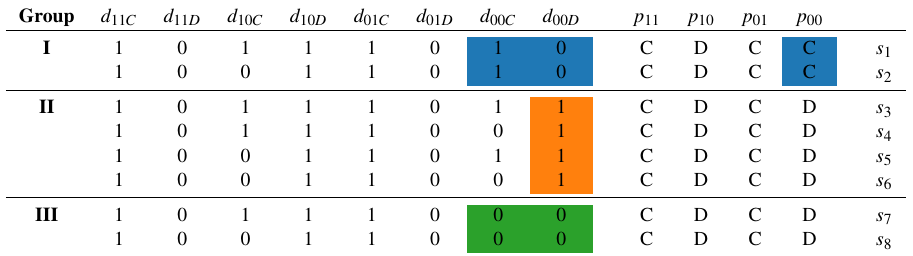
Table 2. Their joint characteristics are displayed in the columns with uniform values 23 . Concerning reputation update, the first column describes the maintenance of cooperation : assigning good reputation for cooperation between good actors. The second and the sixth columns represent the identification of defectors that imposes bad reputation if an actor refuses to cooperate with a good opponent. Justified punishment of bad opponents by good actors is expressed in the fourth column. Forgiveness is displayed in the fifth column: bad actors can gain a good reputation by cooperating with good actors. These joint characteristics highlight the mechanisms shared by norms that enable cooperation to be achieved through indirect reciprocity: (a) cooperation is maintained among cooperators; (b) when defectors enter, they are identified and labelled with bad reputation; (c) bad players are refused help, and those who refuse help to them are not sanctioned; (d) if a player—who has a bad reputa- tion - “apologizes”, he will be forgiven 23 .